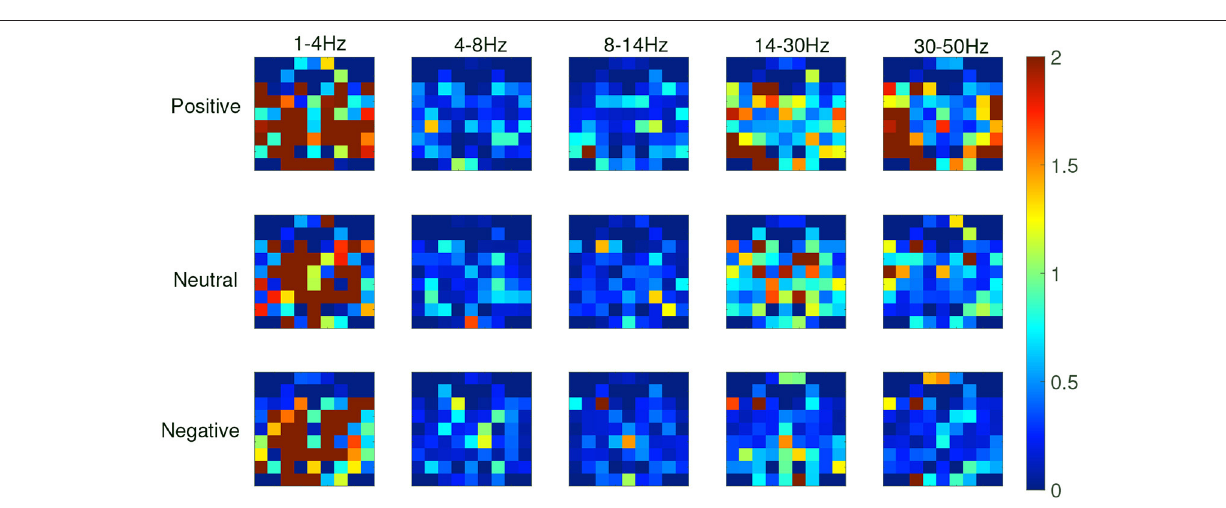
FIGURE 9 | The time-frequency spectrum (TFS) characteristic relative energy map (based on the short-time Fourier transform [STFT] algorithm) corresponds to the electrode arrangement in Figure 2 .